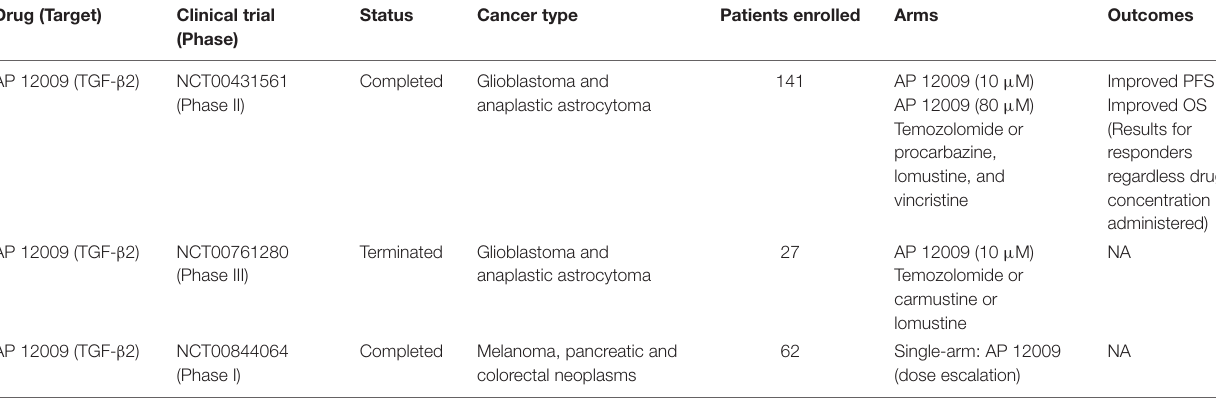
TABLE 1 | Overview of anti-TGF- β therapies based on antisense oligonucleotides used in cancer clinical trials. Drug (Target)